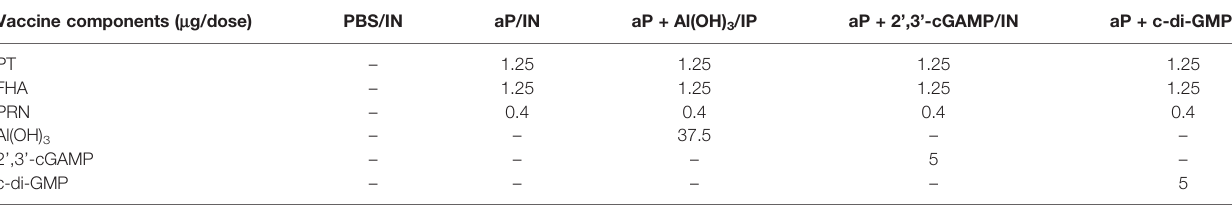
TABLE 1 | The detail of immunization regimens. Vaccine components ( m g/dose)